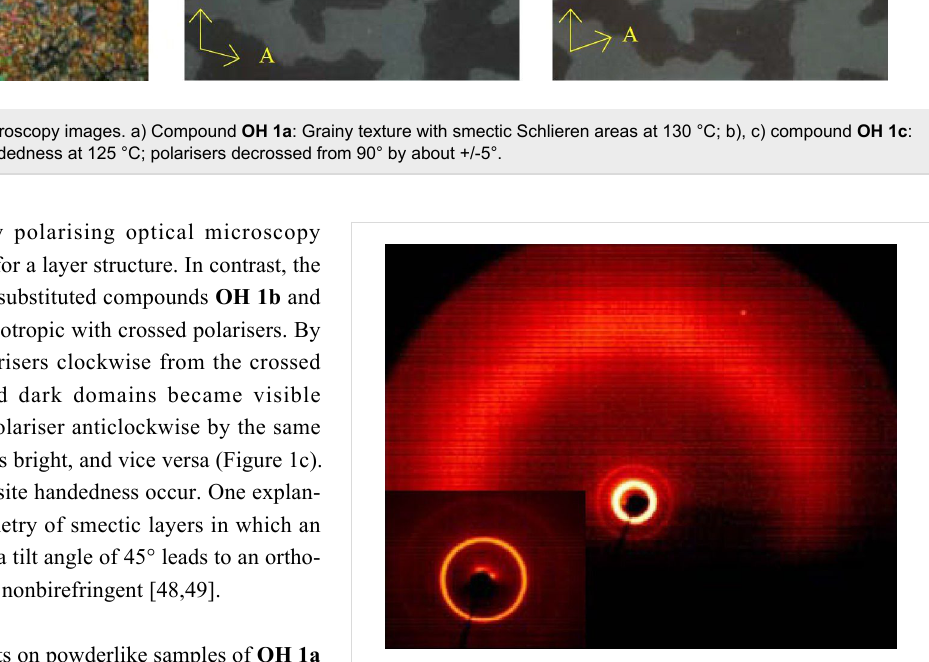
Figure 2: X-ray diffraction pattern of a powderlike sample of OH 1b at 131 °C (inset: Small angle region; lower part of the patterns shadowed by the heating